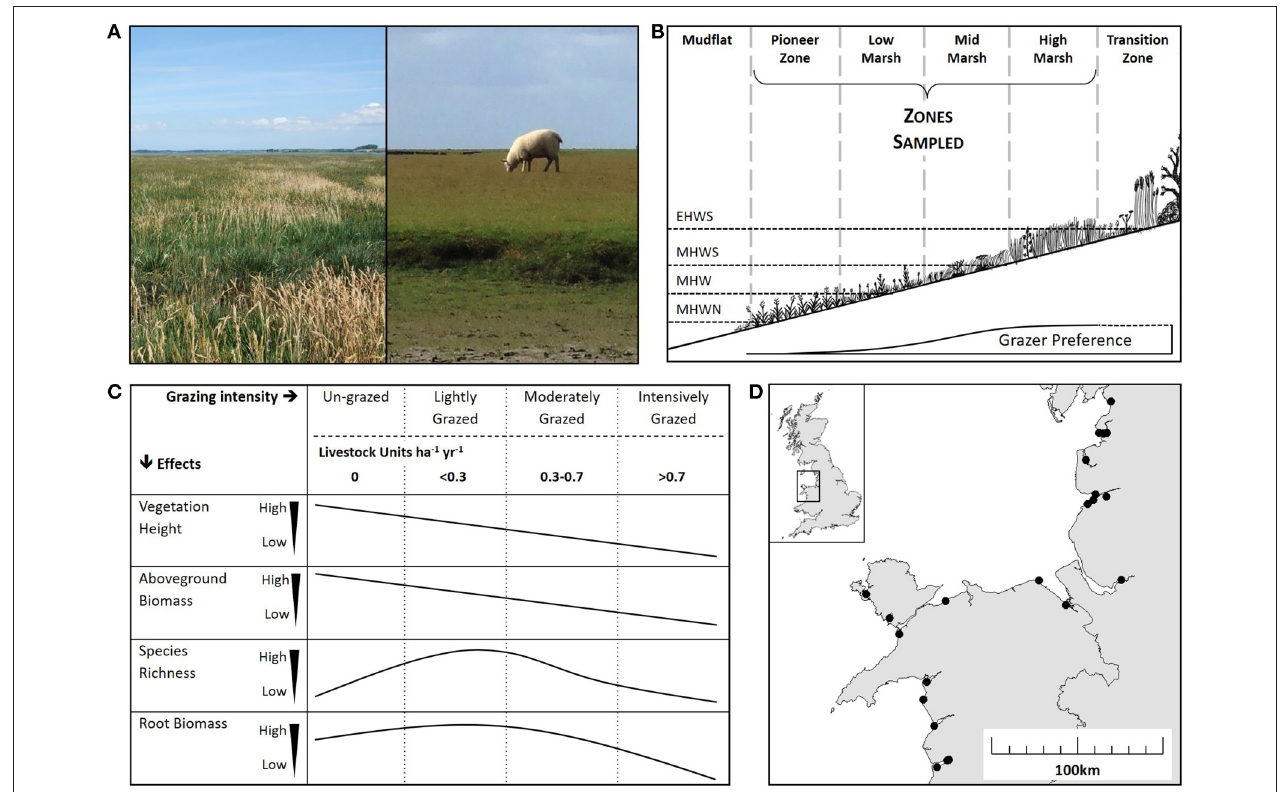
FIGURE 1 | Salt marsh ecology and impacts of grazing. (A) The contrast between an un-grazed marsh (left) and an intensively grazed marsh (right). (B) A diagrammatic representation of a salt marsh showing zonation according to tidal inundation: extreme high-water spring (EHWS), mean high water spring (MHWS), mean high water (MHW) and mean high water neap (MHWN). Only the pioneer, low, mid and high zones were sampled in this study. Grazer preference is indicated showing decreased grazing activity in the lower zones. (C) Predicted effects of a range of grazing intensities on vegetation height, aboveground biomass, species richness and root biomass according to the literature (Stumpf, 1983; Jensen, 1985; Facelli and Pickett, 1991; McNaughton et al., 1998). Grazing is shown as “Grazing Intensity” category classified according to a Welsh Assembly Grazing Management Scheme (un-grazed, lightly grazed, moderately grazed and intensively grazed) and Livestock Units per hectare per year (LSU ha − 1 yr − 1 ). (D) Location of the 22 study sites along the coasts of west Wales and northwest